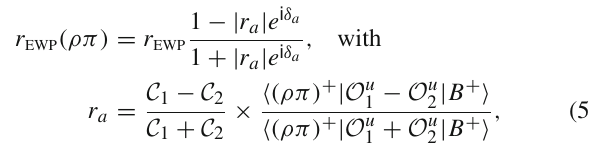
numerical results shown in Fig. 12. The resulting 68% CL intervals